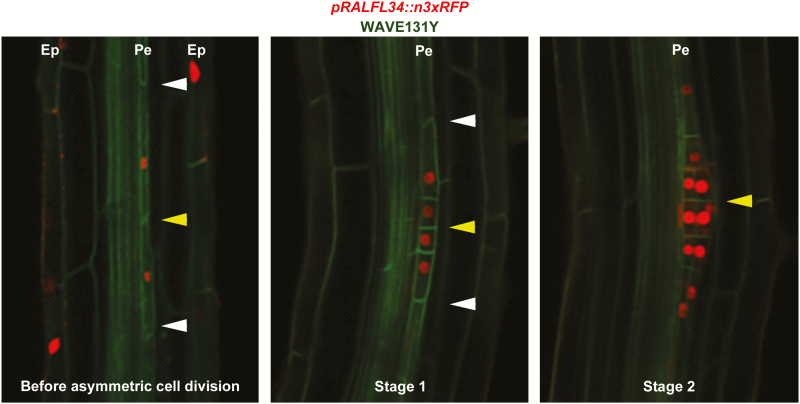

RALFL34 expression during lateral root initiation as visualized through pRALFL34::n3xRFP (red) and WAVE 131Y (green). Arrowheads separate pericycle cells: central (yellow) and outer position (white) for adjacent pericycle cells undergoing two rounds of asymmetric cell divisions. Lateral root development stages are indicated. Ep, epidermis. Pe, pericycle (at xylem pole).